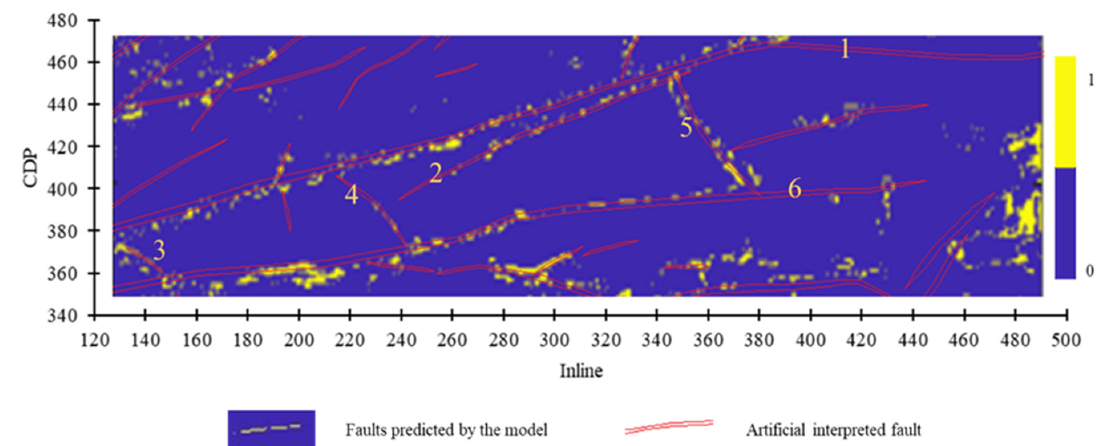
Figure 11. Results of Faults 1–6 predicted by Model 2.